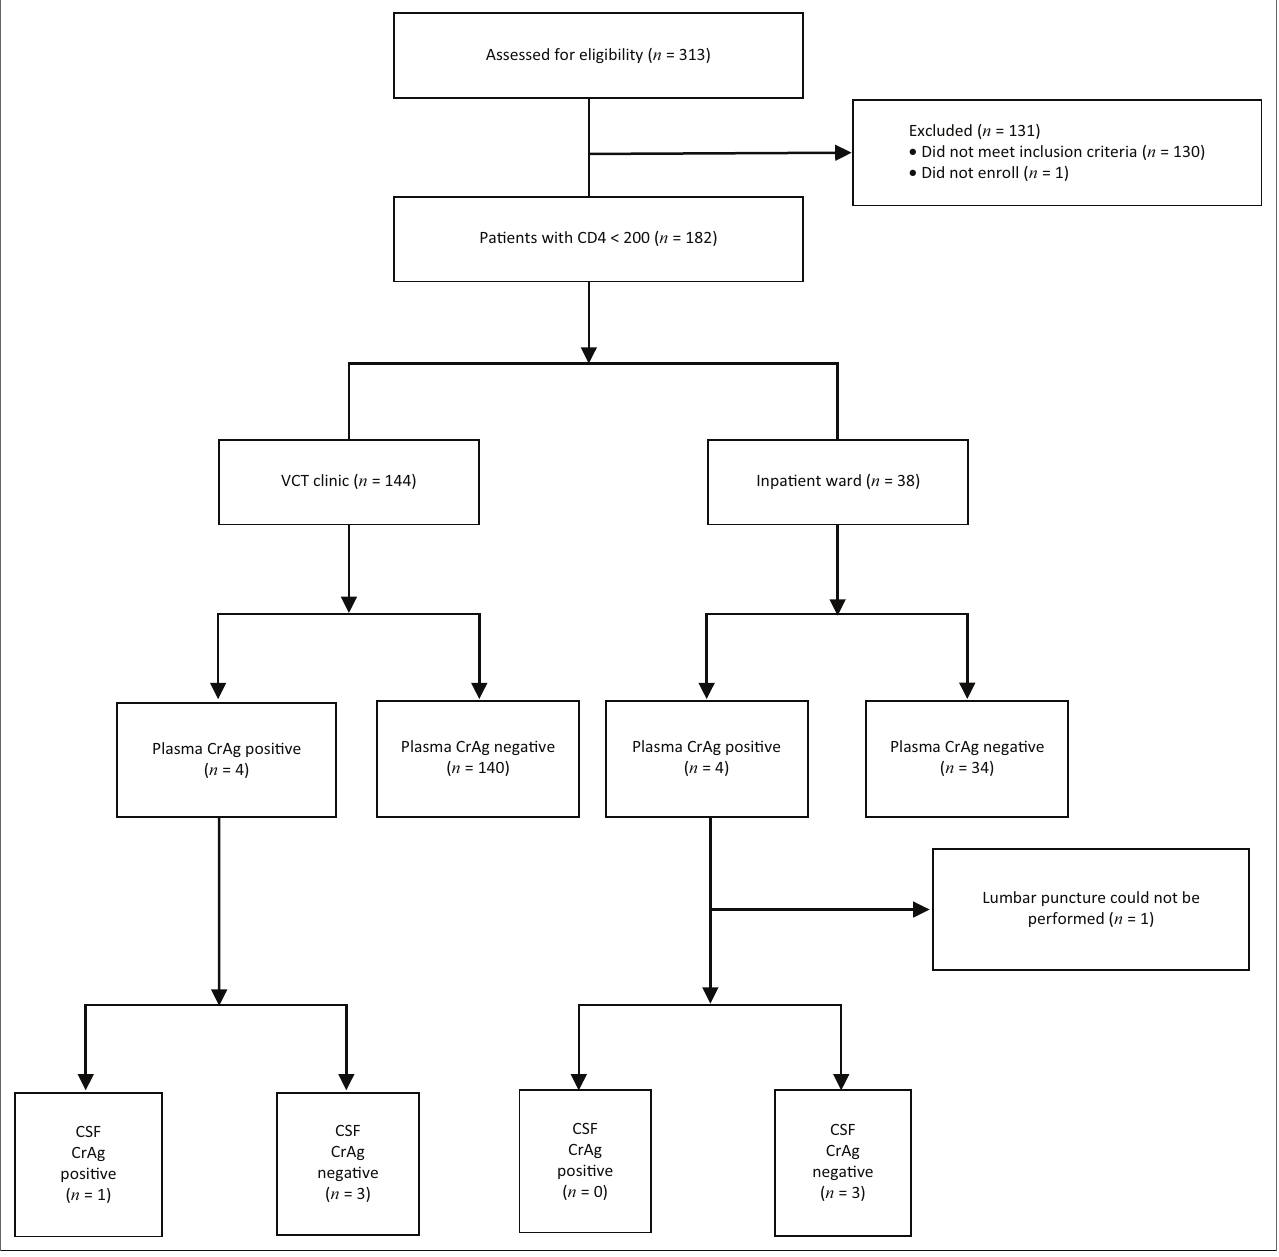
FIGURE 1: Study flow for cryptococcal screening at Mbabane Government Hospital, Eswatini, August 2014 to March